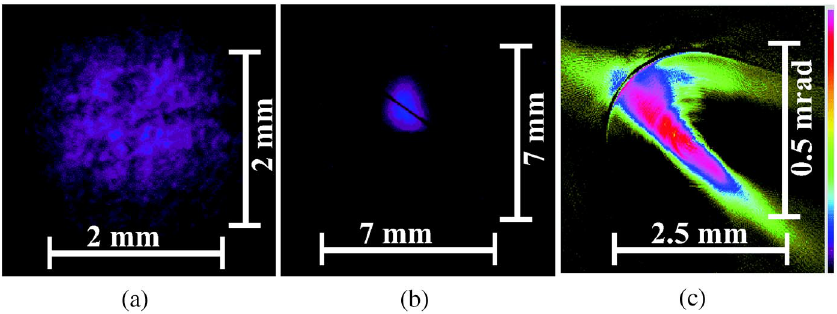
FIG. 7. (Color) Gaussian derived directly from the laser output. (a) The laser intensity profile, (b) the electron beam profile at HPOP-UP1 location, (c) the tomographic recovery of the electron beam’s transverse phase space.